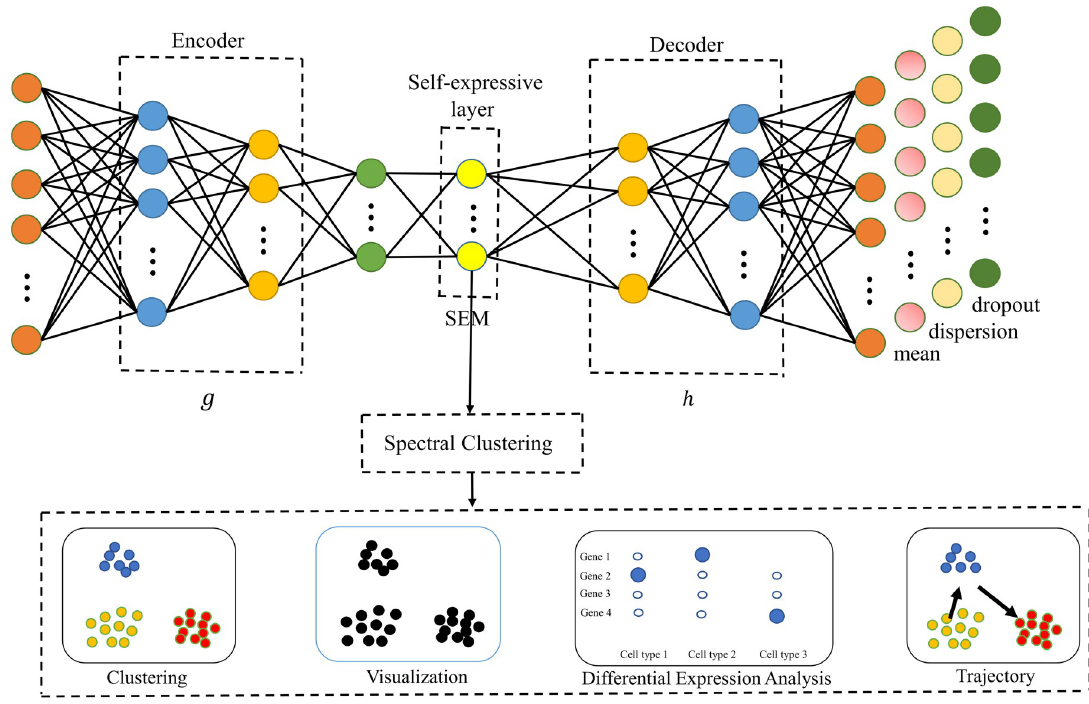
Fig 1. Network architecture of scDSSC. An autoencoder based on ZINB distribution is constructed, in which the encoder and decoder can be seen as two nonlinear mappings g and h. The output of the hidden layer is a low dimensional data, which is considered to be the data after dimension reduction and noise reduction. After the last layer of the decoder, four full connection layers are connected, which respectively generate reconstruction data and three parameters in the ZINB distribution. The output of self-expressive layer is self- expressive matrix (SEM), which is sparse and used to perform spectral clustering. According to the clustering results, a series of downstream analysis are applied to verify the performance of the model.